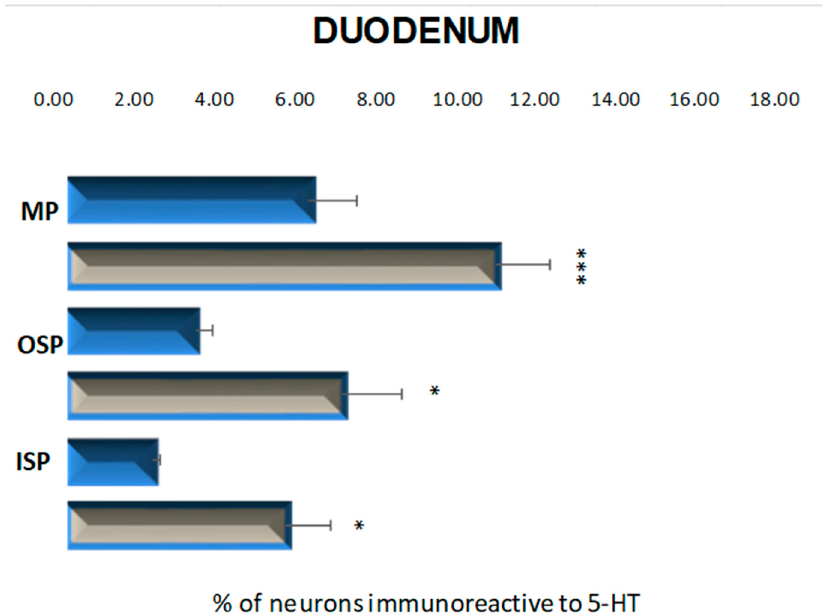
Figure 3. Schematic diagram of the proportion of perikarya immunoreactive to 5-HT of the control (blue bars) and experimental group (grey bars) in the particular parts of duodenum. OSP—the outer submucosal plexus; ISP—the inner submucosal plexus; MP—the myenteric plexus. * p < 0.05 and *** p < 0.001 indicate differences between all groups for the same neuronal population.